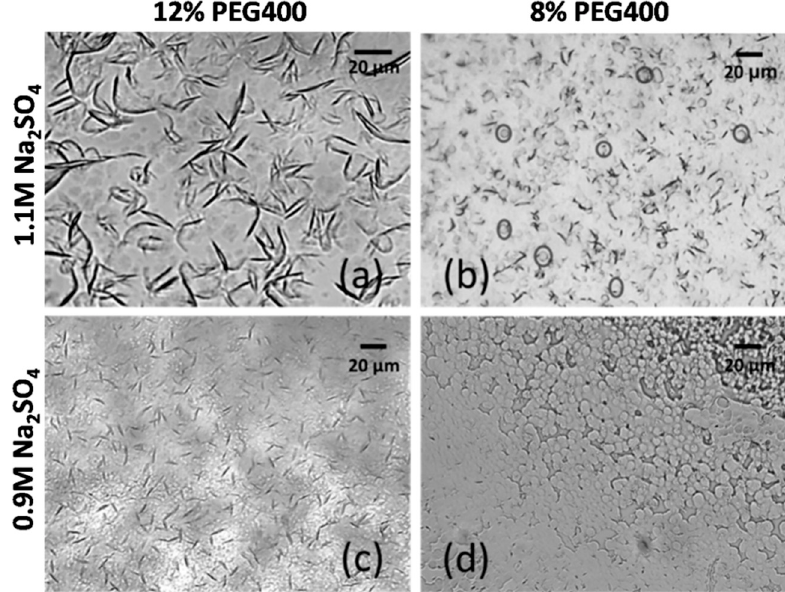
Figure 4. Visible microscopy images of anti-CD20 crystals obtained through hanging drop vapor diffusion after seven days of equilibration. Crystals were obtained using 30 mg/mL anti-CD20 and a crystallization solution containing ( a ) 1.1 M Na 2 SO 4 and 12% ( w / v ) PEG400, ( b ) 1.1 M Na 2 SO 4 and 8% ( w / v ) PEG400, ( c ) 0.9 M Na 2 SO 4 and 12% ( w / v ) PEG400, and ( d ) 0.9 M Na 2 SO 4 and 8% ( w / v ) PEG400. Crystallizing solutions were buffered by 0.1 M HEPES at pH 7.7. Phase separation is shown by a gray circle in (b).